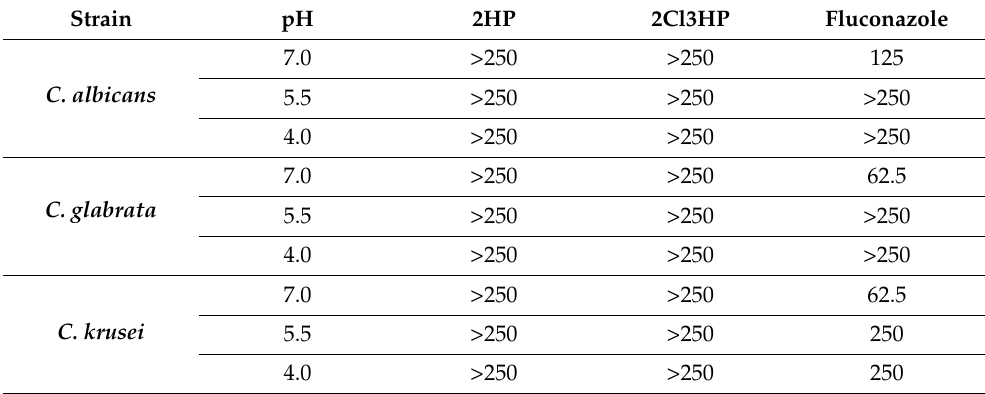
Table 6. The antifungal activity of investigated compounds is defined as MIC [ µ M]. Fluconazole was used as a